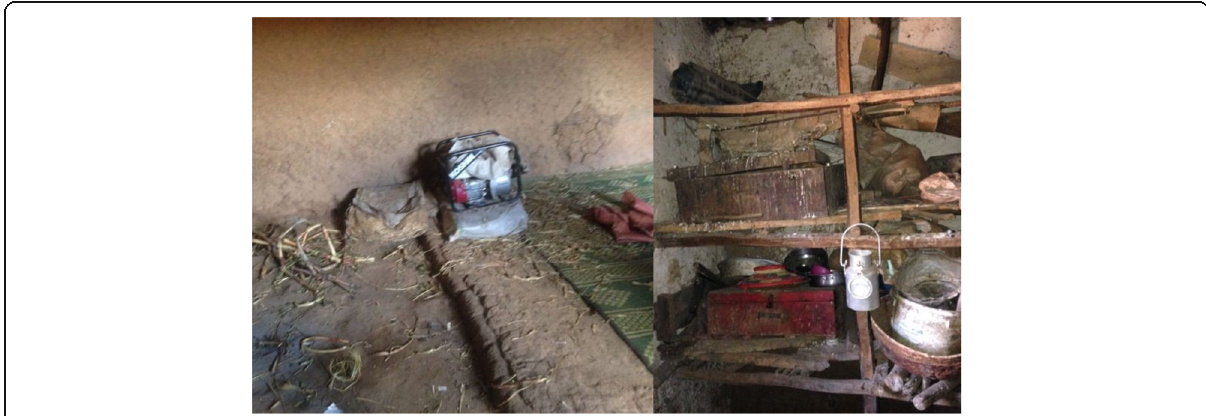
Fig. 3 A typical division between human and animal sleeping quarters (left) as well as a chicken sleeping roost directly above the kitchen (right), note the high volume of chicken